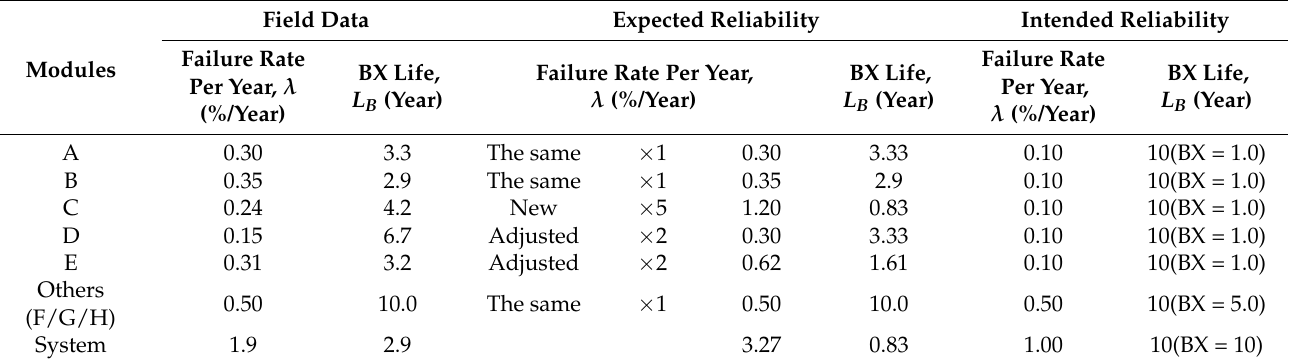
Table 1. Comprehensive ALT scheme of mechanical modules (or subsystems) in a product such as